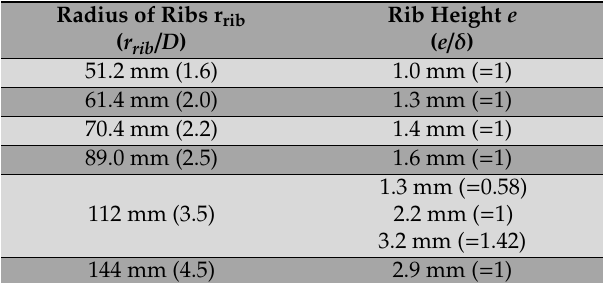
Figure 3. Circular ribs and vortex generator.